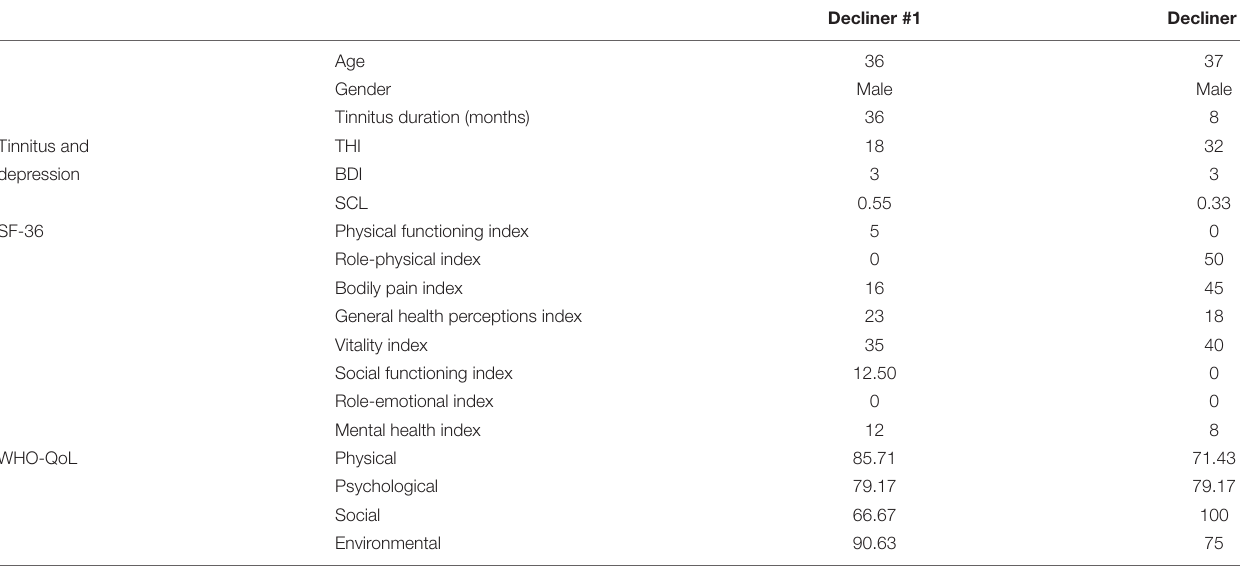
TABLE A1 | Demographic, health, and tinnitus characteristics of the two individuals of the decliner